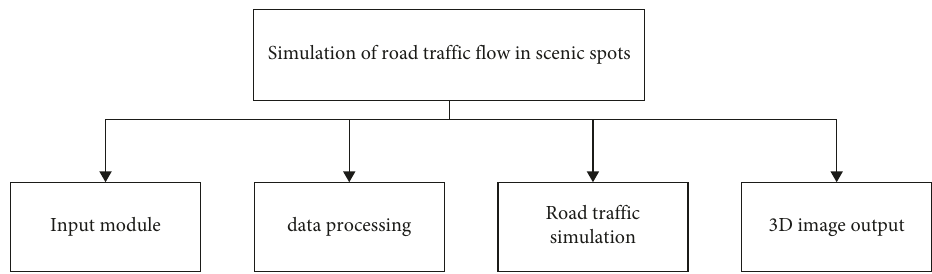
Figure 4: Software framework of the prototype